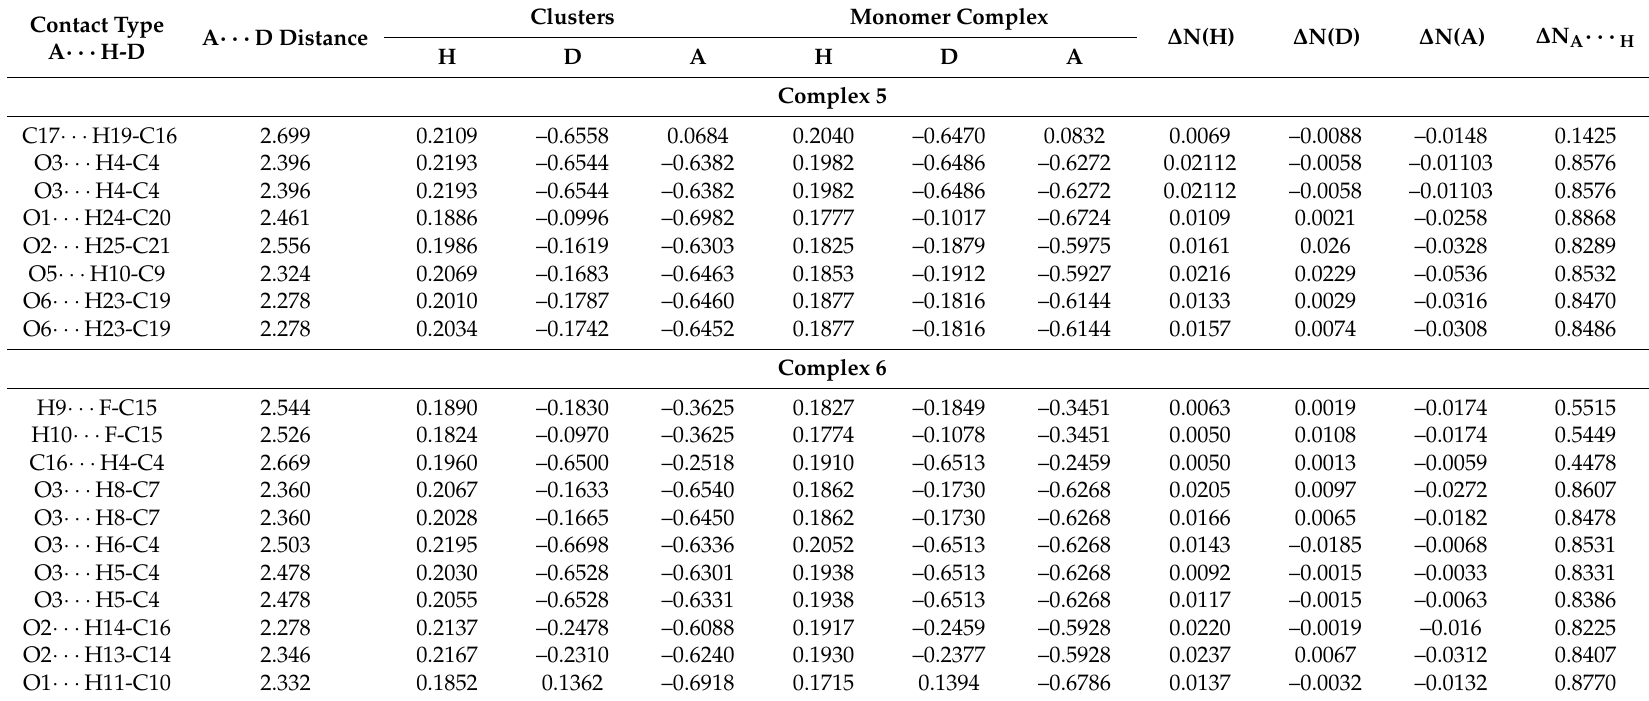
Table 3. Calculated natural charges at the D-H · · · A sites using the B3LYP